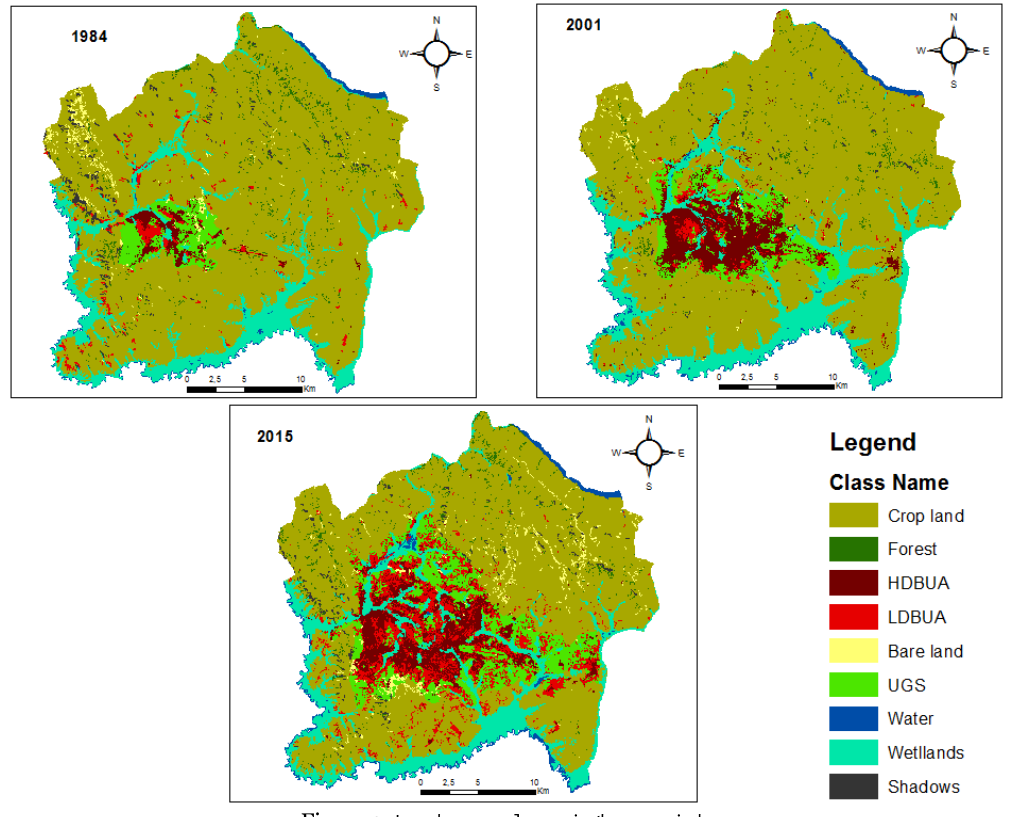
Figure 2 : Land cover classes in three periods Table 2: Classification accuracies and Kappa Coefficients